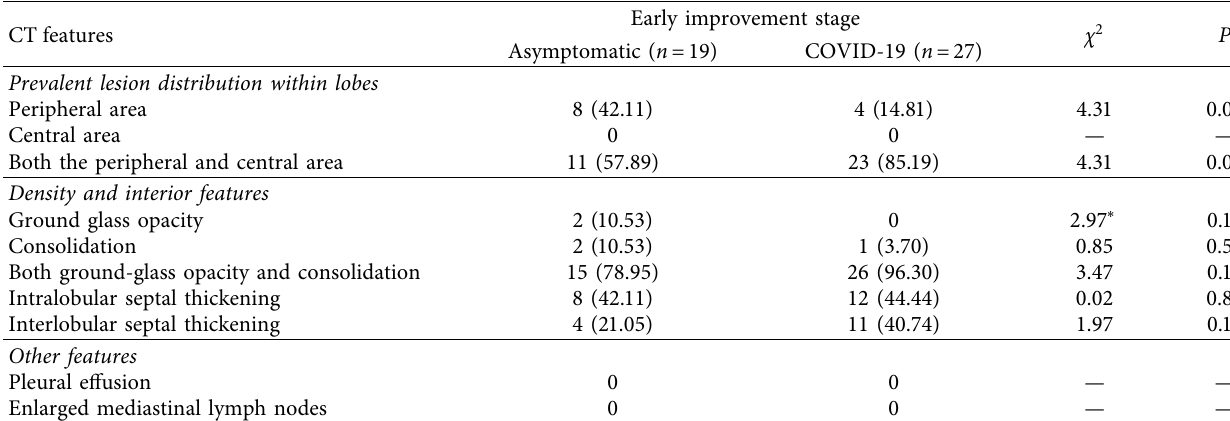
Table 5: Imaging features of asymptomatic carriers and COVID-19 patients at the early improvement stage. CT features